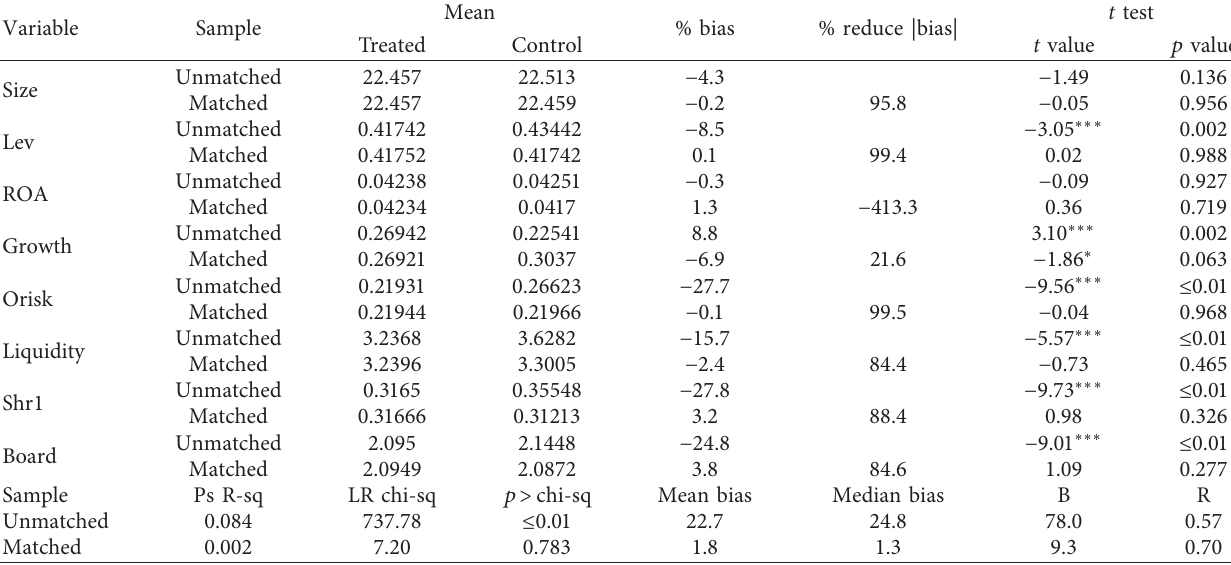
Table 7: The balancing test results of